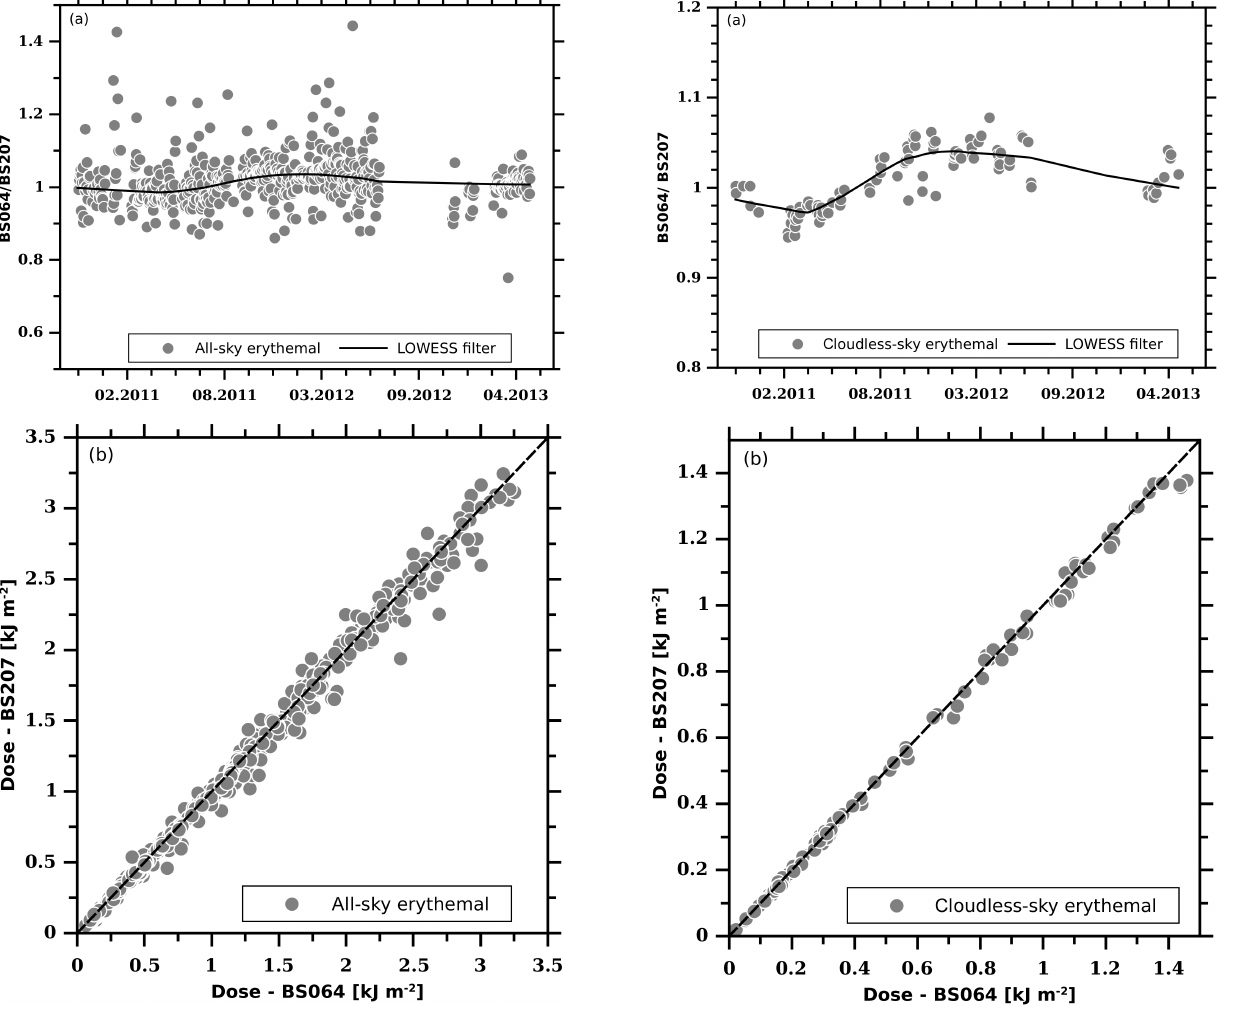
Figure 2. (a) Same as Fig. 1a but for cloudless-sky conditions and 3h doses calculated for the period before noon (noon − 3.5h, noon − 0.5h). (b) Same as Fig. 1b but for cloudless-sky conditions and 3h doses calculated for the period before noon (noon − 3.5h, noon −